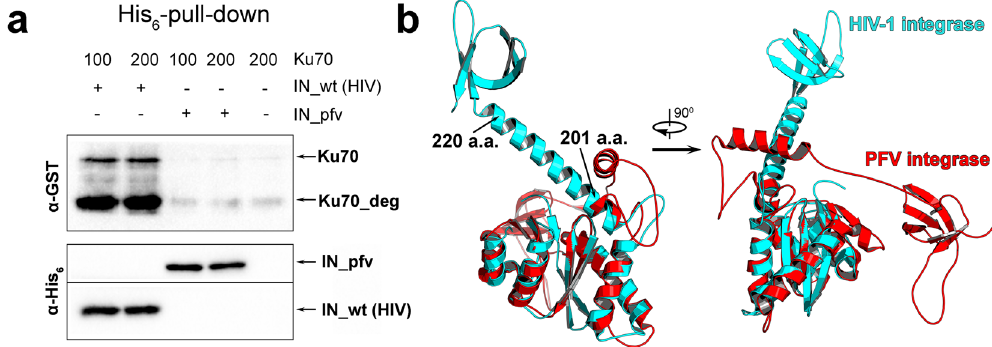
Figure 3. Ku70 interaction with IN HIV-1 and IN PFV. ( a ) His 6 -pull down assay for the binding of HIV-1 IN (IN_wt) or PFV IN (IN_pfv) with Ku70. Ku70 concentration (nM) marked above, both integrases taken at a 100 nM concentration. ( b ) Comparison of two-domain structures (catalytic + С-terminal domain) of HIV-1 IN